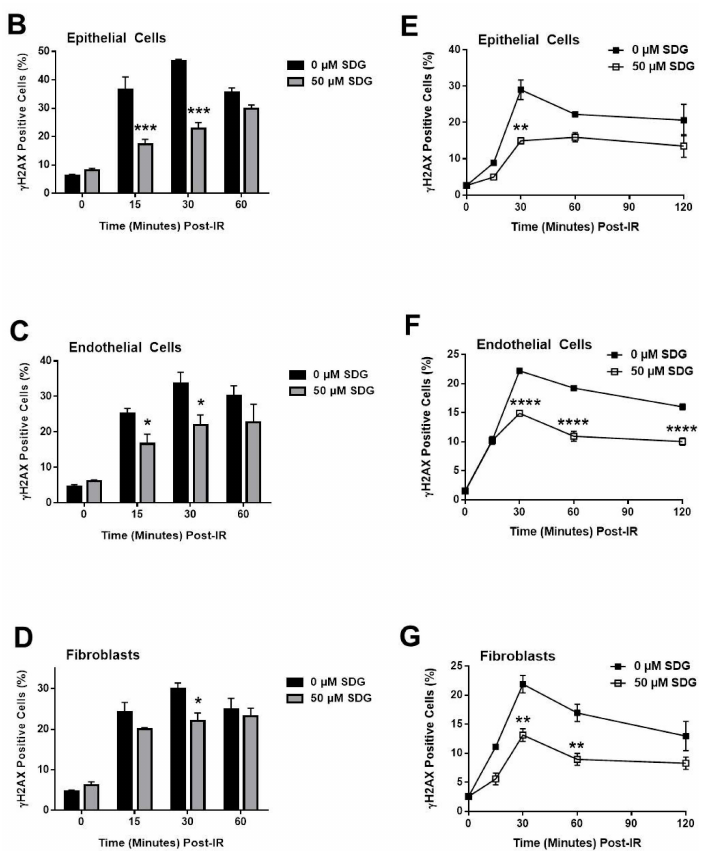
Figure 2. Evaluation of γ -H2AX foci in irradiated murine epithelial cells, endothelial cells and wild-type fibroblasts. ( A ) Representative panels of immunofluorescence visualization of γ -H2AX foci (green) in murine lung epithelial cells at 200 ˆ magnification. Cells were pre-treated with SDG for 6 h and irradiated with γ -rays (2 Gy); ( B – D ) Evaluation of DNA damage by γ -H2AX foci counting on ( B ) Epithelial Cells, ( C ) Endothelial Cells, and ( D ) Fibroblasts; ( E – G ) Flow cytometric (FACS) analysis of γ -H2AX foci in irradiated murine lung cells ( E ) Epithelial Cells, ( F ) Endothelial Cells, and ( G ) Fibroblasts. Cells were treated with SDG (50 µ M) for 6 h and gamma-irradiated (2 Gy). At desired time interval, cells were processed for FACS analysis. Data were quantified using Summit software and is represented as mean ˘ SEM. * indicates p < 0.05, ** indicates p < 0.01, *** indicates p < 0.001, **** indicates p < 0.0001 for irradiated cells vs. SDG pre-treated irradiated